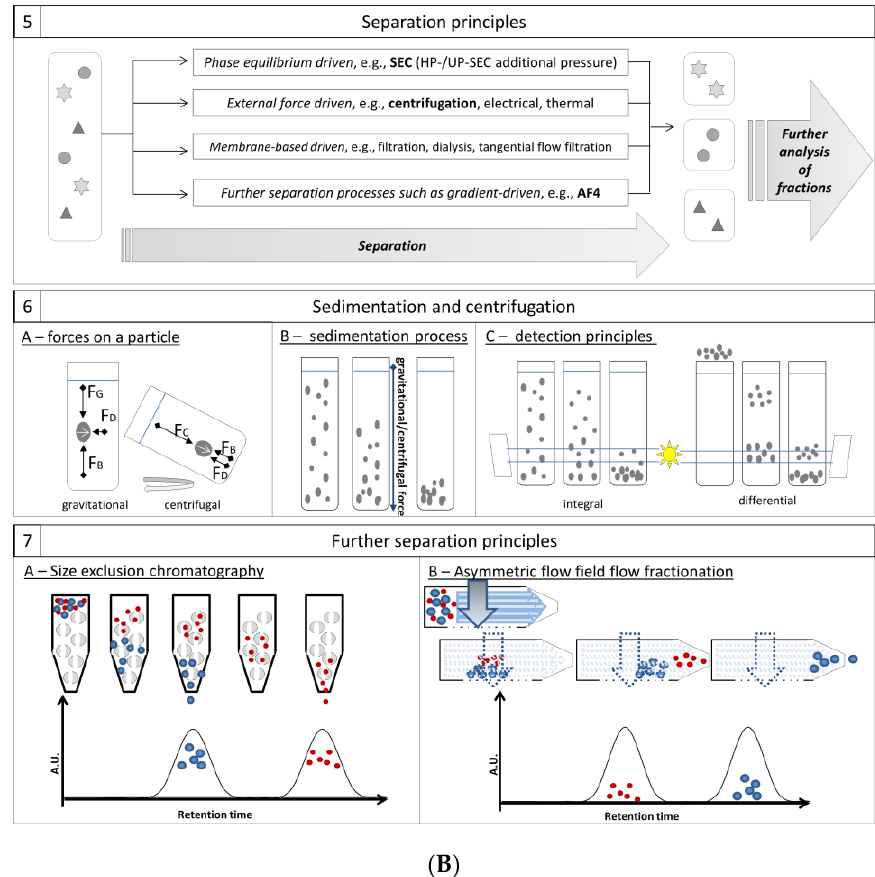
Figure 3. ( A ) Schematic illustration of important particle detection principles. The major principles of particle detection techniques, particle–light interactions ( 1 ), microscopy and imaging ( 2 ), resistive pulse sensing or Coulter principle ( 3 ), and suspended microchannel resonators ( 4 ) are